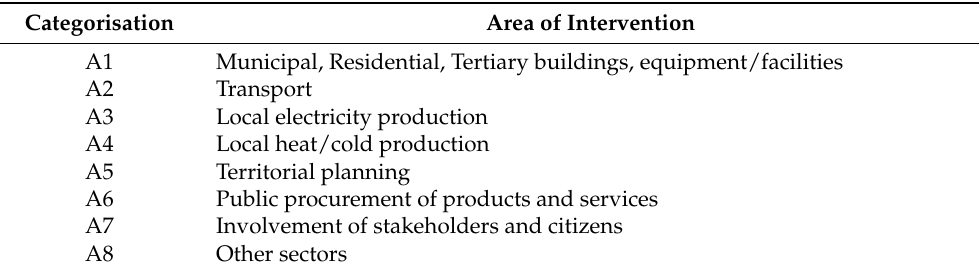
Table 12. Categorisation of the